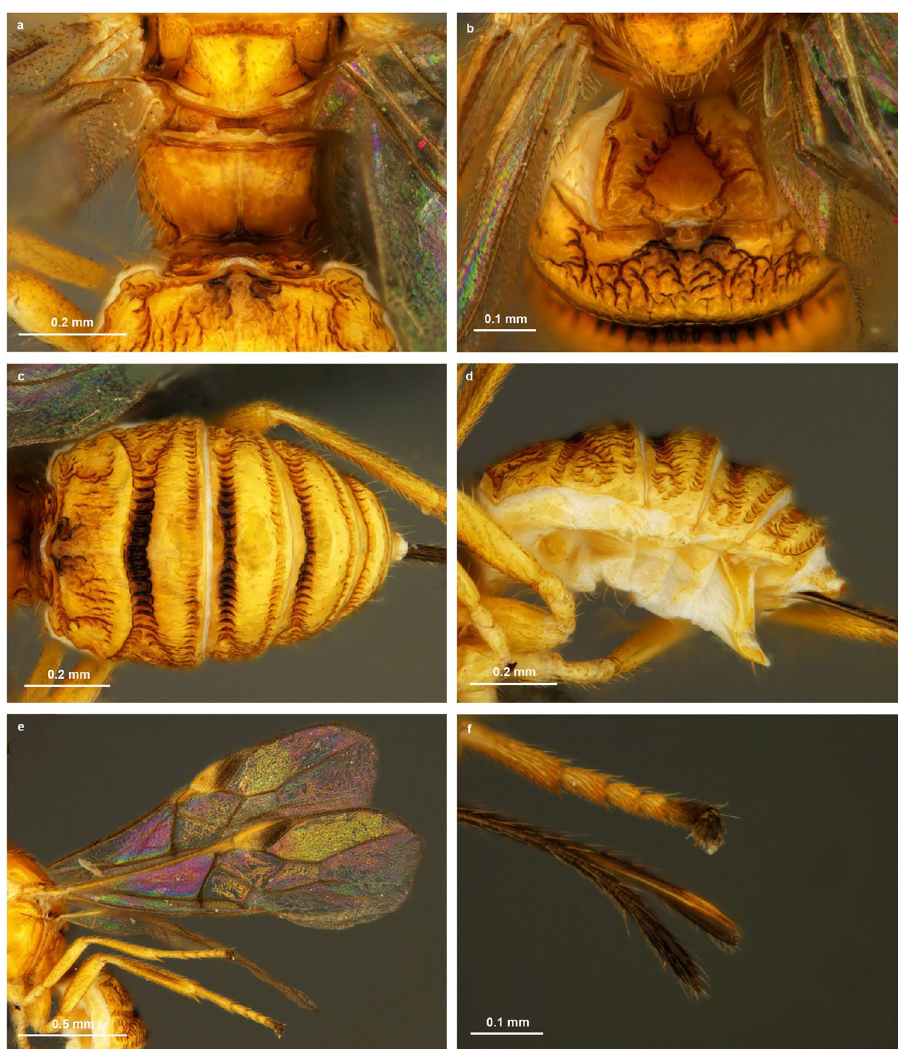
Figure 5. Light microscopic images of Bracon predatorius Ranjith & Quicke sp. nov., holotype, female. (a ) Propodeum, in dorsal view, ( b ) first and second metasomal tergite, in dorsal view, ( c ) metasoma, in dorsal view, ( d ) metasoma, in lateral view, ( e ) wings, ( f ) ovipositor and ovipositor